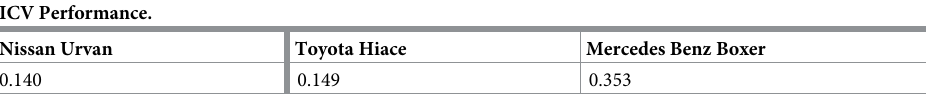
Table 5. ICVs Toyota, Nissan and Mercedes Benz performance. ICV